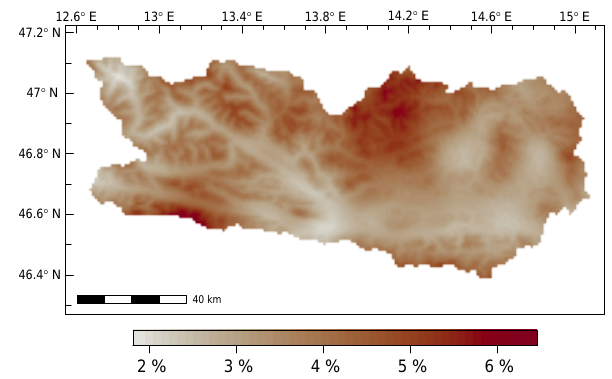
Figure 6. Climatological probability (expected values) of lightning in Carinthia on the 1km × 1km scale for 20 July computed with a generalized additive model